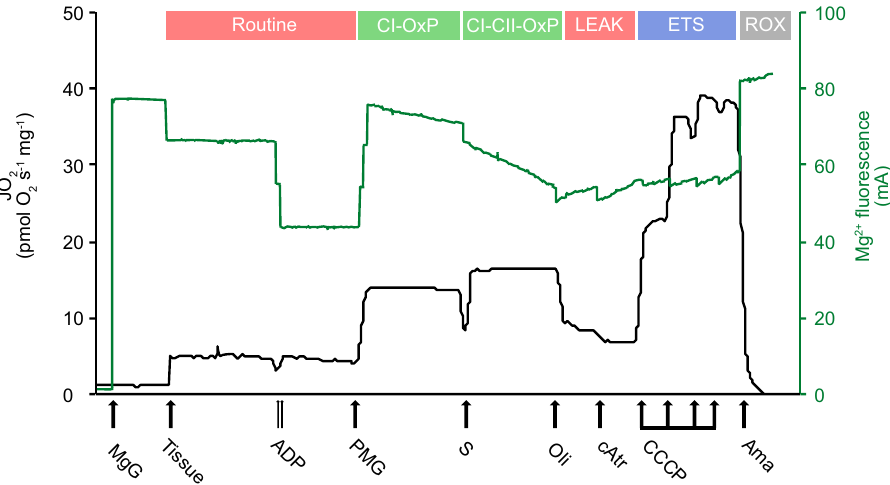
Figure 2. Representative trace of mitochondrial respiration assay from triplefin brain homogenates. Mitochondrial flux (pmol O 2 s −1 mg −1 ) on the left axis and Mg 2+ fluorescence (mA) on the right axis. Addition of tissue and titration of mitochondrial substrates and inhibitors at saturated concentrations are indicated by the arrows and follow the SUIT protocol outlined above. ADP Adenosine diphosphate, P Pyruvate, M Malate, G Glutamate, S Succinate, Oli Oligomycin, cAtr Carboxyatractyloside, CCCP Carbonyl cyanide m-chloro phenyl hydrazone, Ama Antimycin A. Different mitochondrial states are represented above the